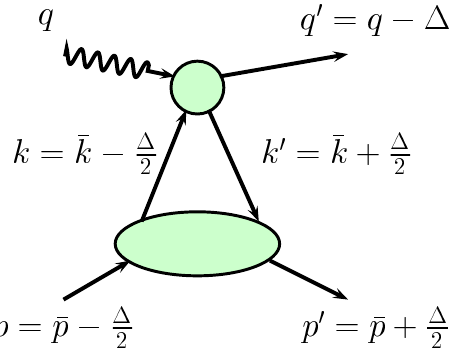
Figure 1. The handbag diagram for the meson photoproduction o ff